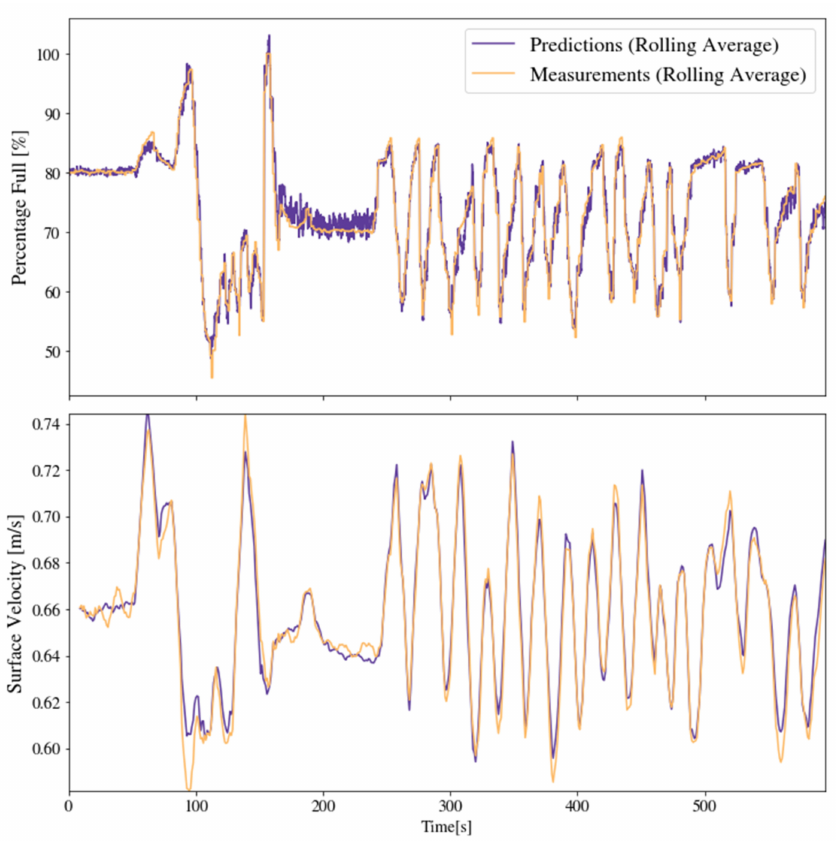
Figure 3. Water Level and Surface Velocity Measurements and Predictions Using the CNN of Scenario 1. Both the measurements as well as the predictions are smoothed using a rolling